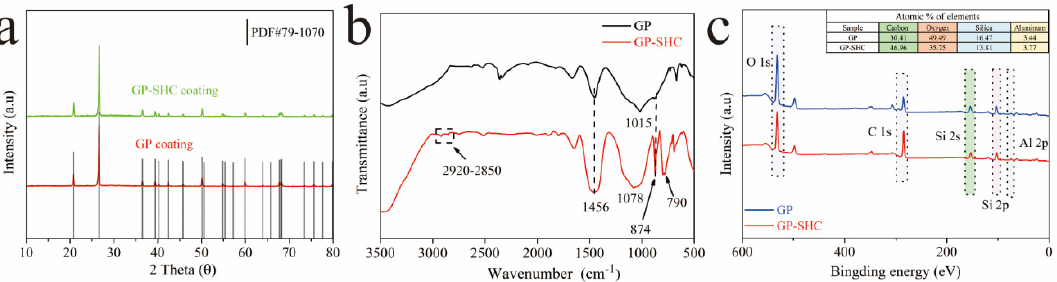
Figure 4. ( a ) XRD spectra of the AAS coatings of GP and GP-SHC, ( b ) FT-IR spectra of the AAS coatings of GP and GP-SHC, ( c ) XPS full spectra of the AAS coatings of GP and GP-SHC.